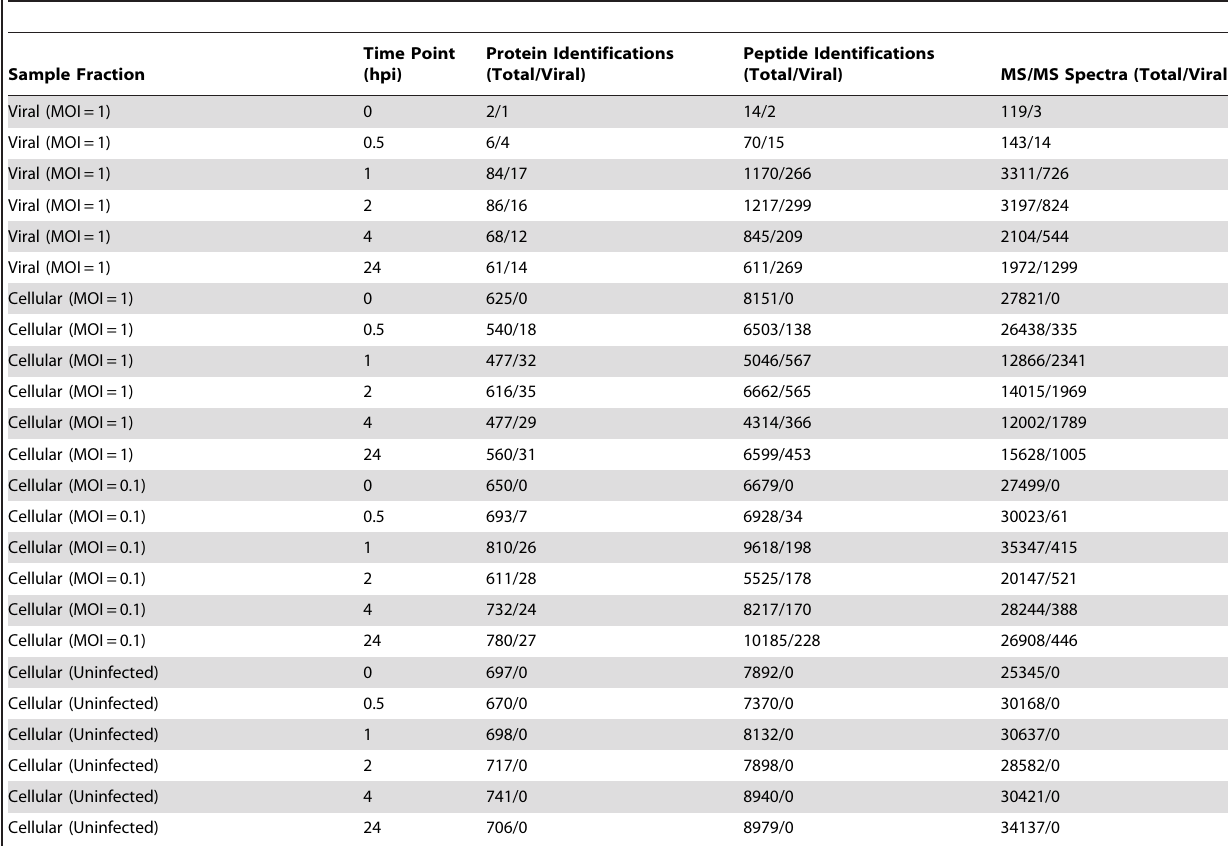
Table 1. Number of proteins, peptides, and spectra identified by LC-MS/MS in cellular (MOI =0.1 and 1) or PEG-enriched viral fractions (MOI =1) at each time point of